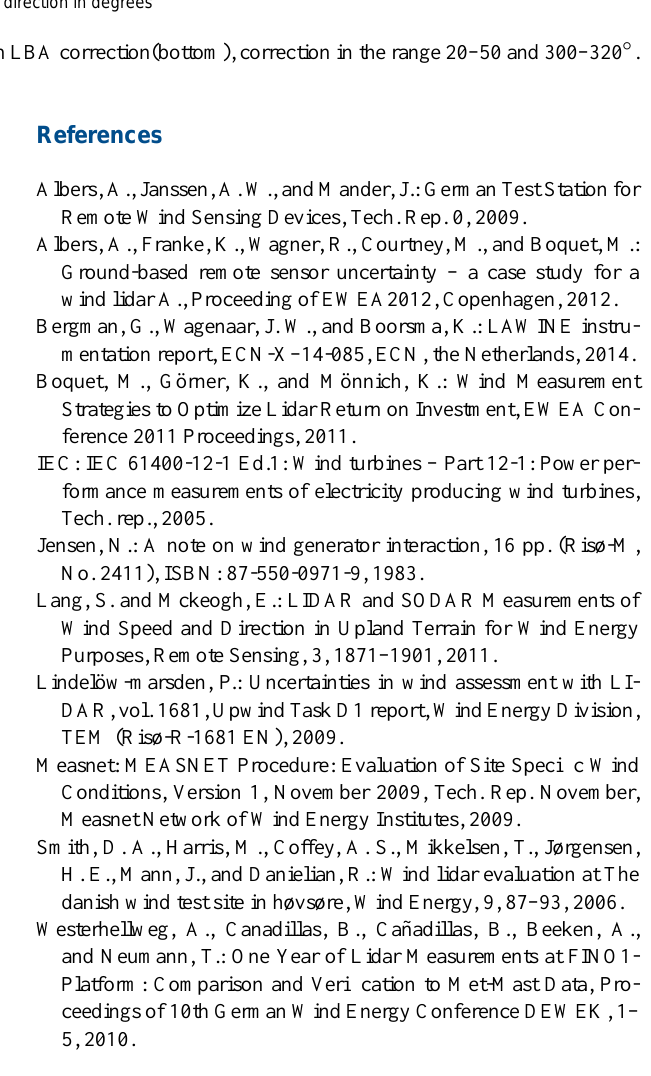
Figure 6. Wind speed ratio representing wakes without(top) and with LBA correction(bottom), correction in the range 20–50 and 300–320 ◦ .